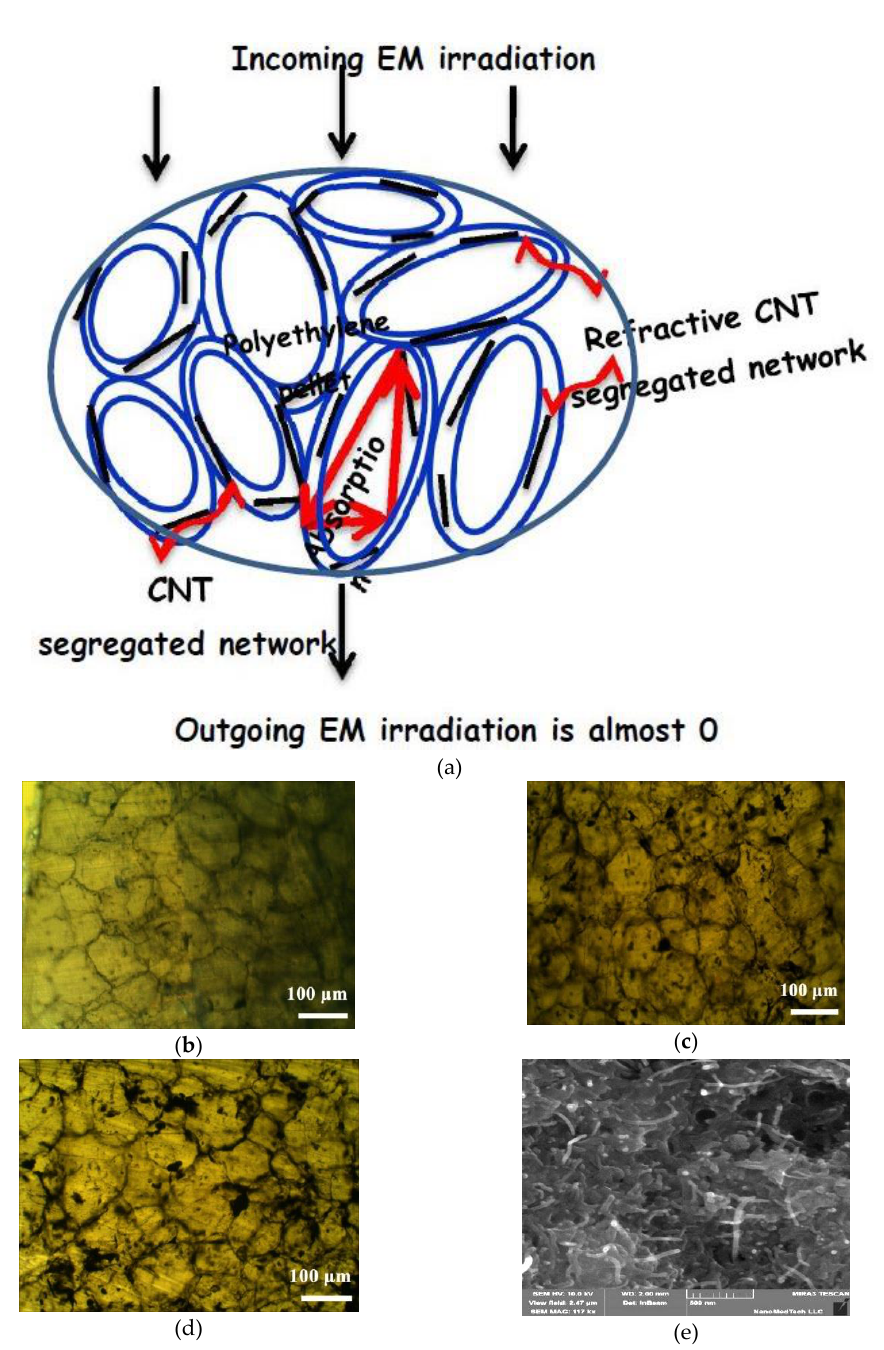
Figure 2. The scheme of segregated structure of composite CNT/PE (a), optical images of CNT conductive network formation with increasing filler content in segregated CNT/PE composite materials (CMs): (b) 0.05%, below 𝜑 𝑐 (c) 0.1%, at 𝜑 𝑐 ; (d) 0.2%, above 𝜑 𝑐 and SEM-image of random 1% CNT/epoxy composite (e)